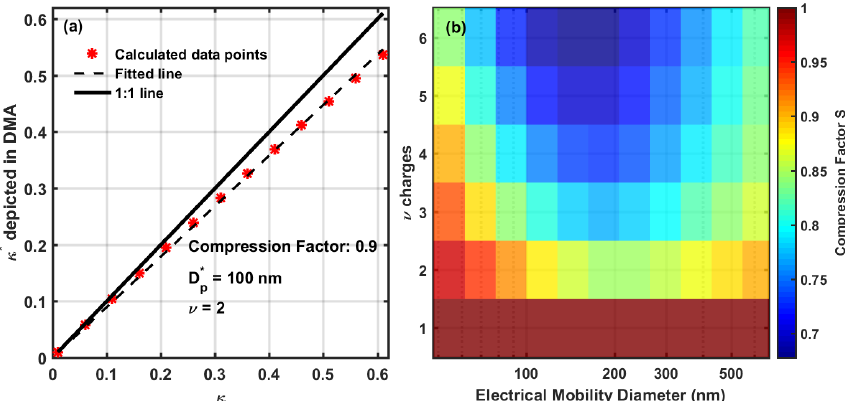
Figure 3. (a) The compression effect on the hygroscopicity (at 85% RH) for doubly charged particles with an electrical mobility diameter of 100nm. The fitted slope or compression factor is 0.8953. (b) A summary of the compression factors for different electrical mobility diameters and different charge numbers at 85%